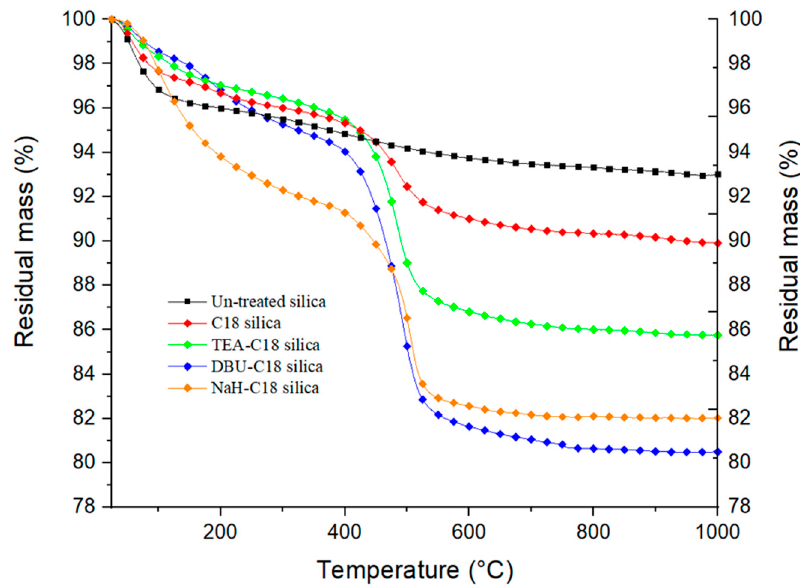
Figure 3. Thermogravimetric curves of untreated and C18 − silanized silica.